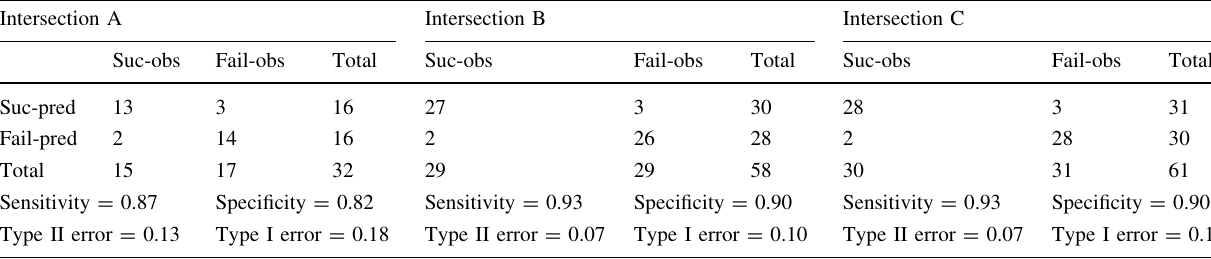
Table 6 Prediction success table (considering aggressive behavior)